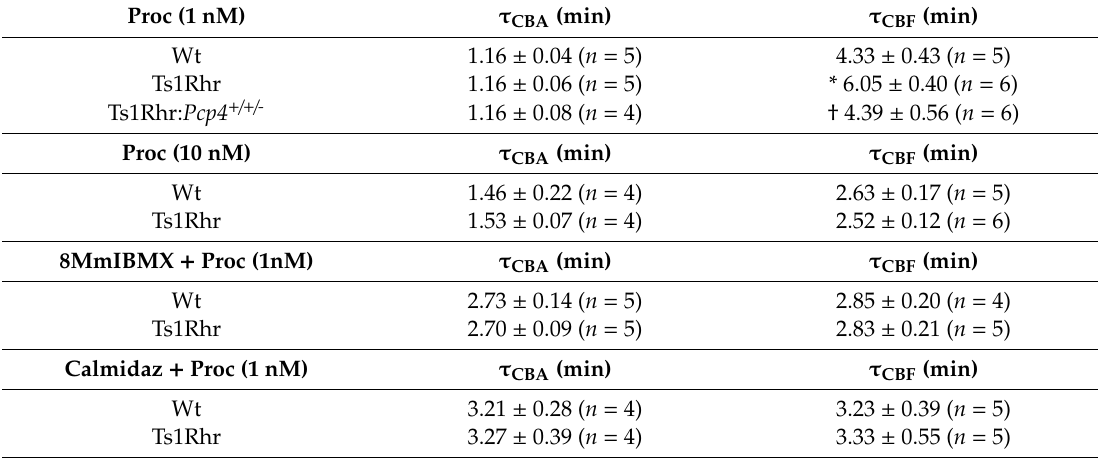
Table 3. Time constant “ τ ” calculated from the fitted